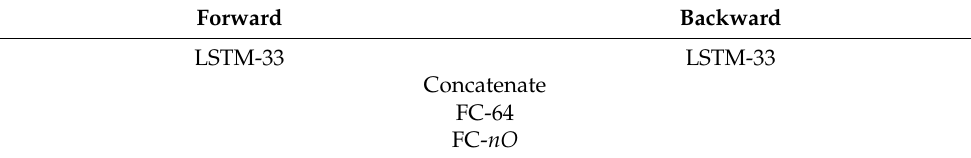
Figure 9. Structure of RNN-based DDP model. Table 10. Network parameters for the proposed RNN-based DDP model.